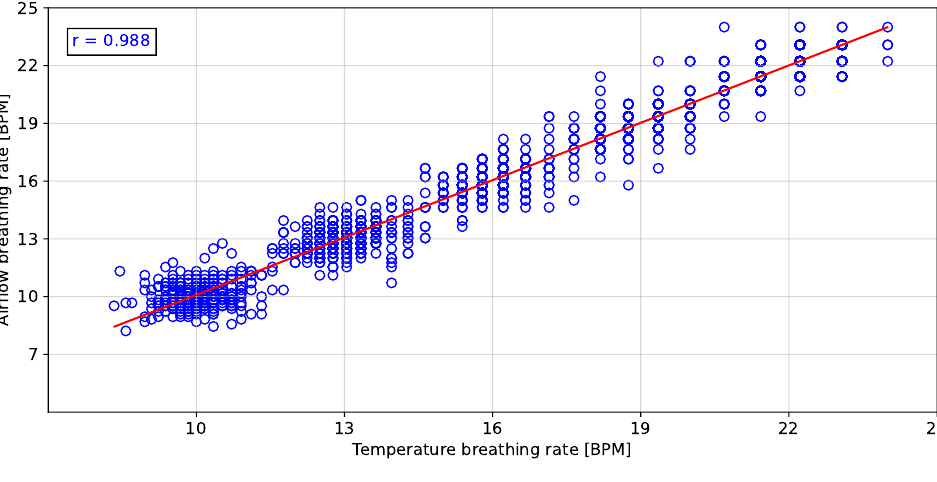
Figure 13. Pearson correlation of the breathing rate from the temperature signal respect to the airflow